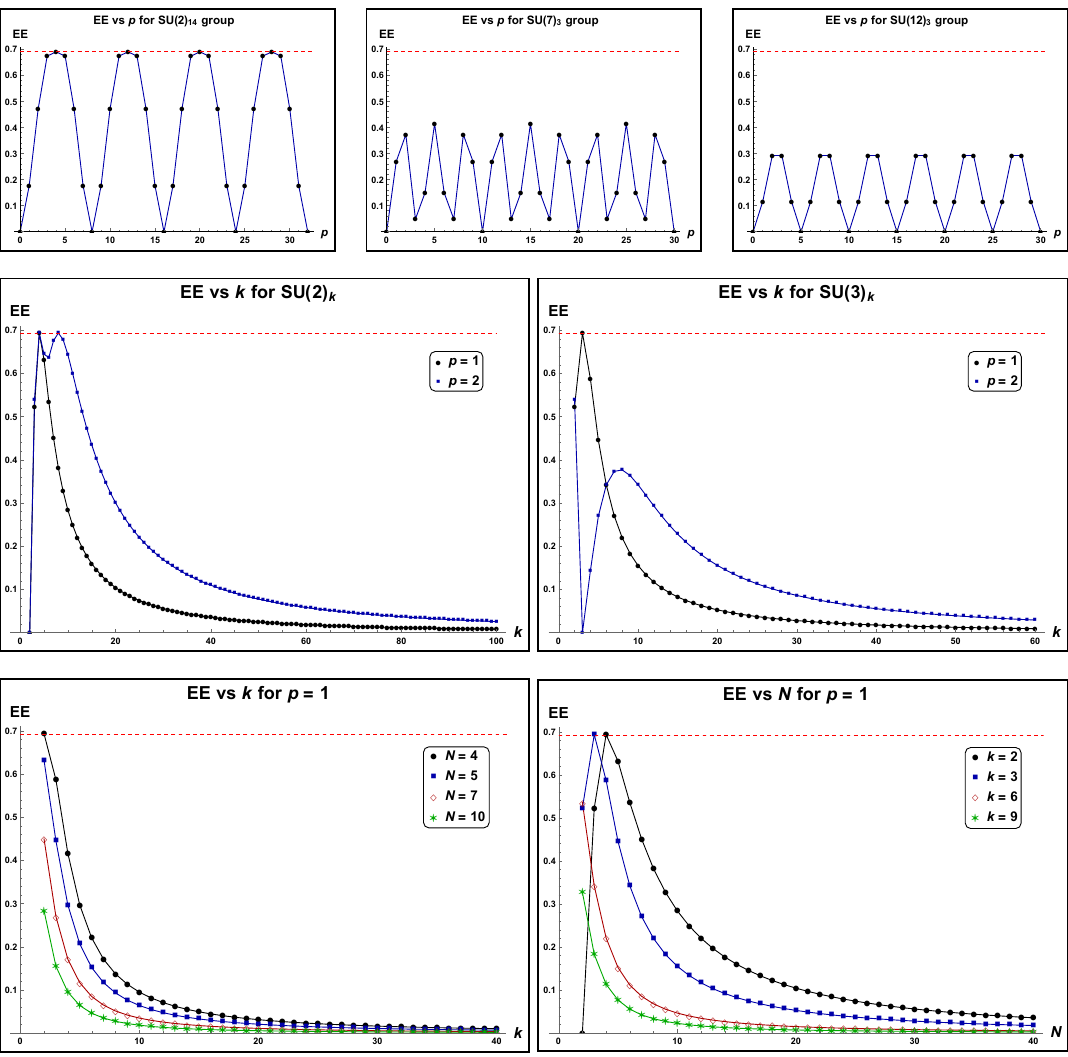
i as a function of k , N and 3